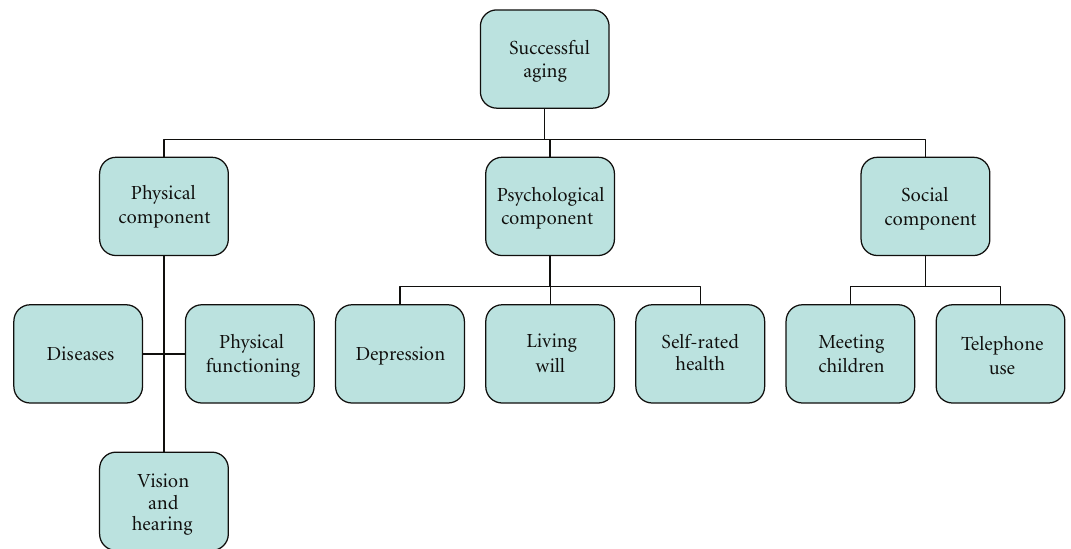
Figure 1: Three components of successful